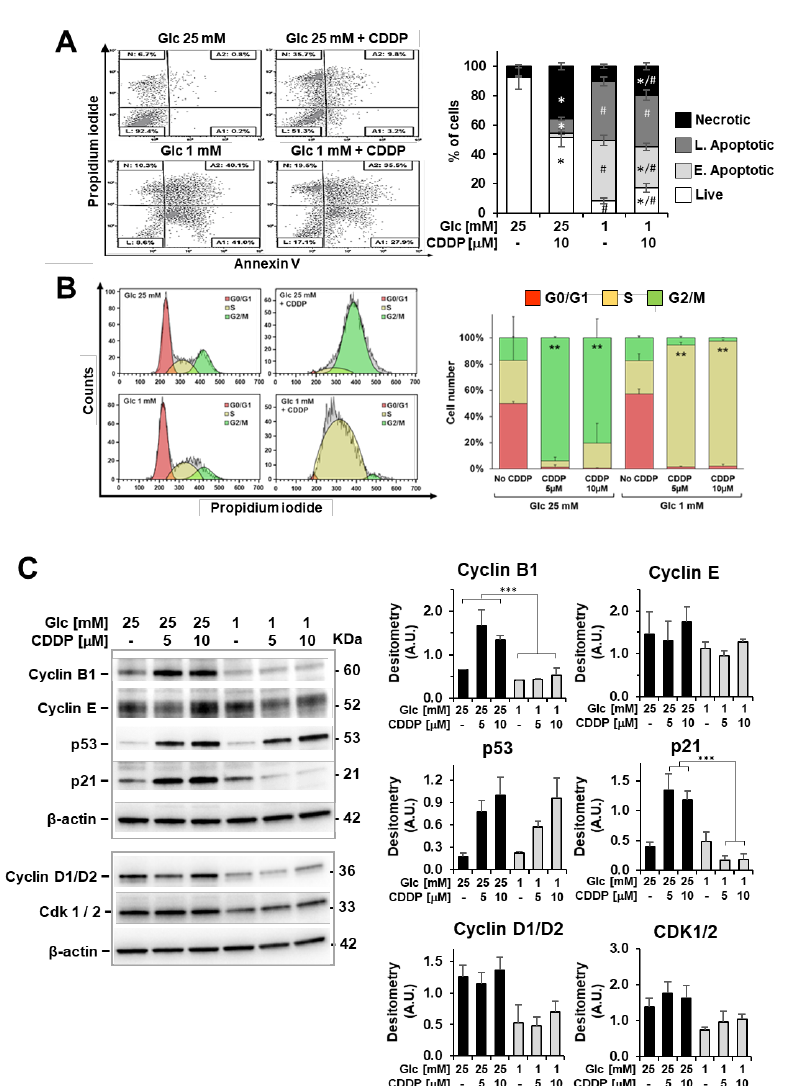
glucose pretreated 3AB-OS cells to CDDP. Left panel, representative growth curves of 3AB-OS cells pretreated with low glucose for 2 days and then exposed to CDDP (5 and 10 µM) or vehicle in low glucose nutrient medium for 72 h. Right panel, bar histogram: NCI values of low glucose-pretreated 3AB-OS cells relative to control (Glc 1 mM) after 72 h treatment. All data are presented as mean ± SD of three independent experiments. * p < 0.05; ** p < 0.01. Statistical significances are referred to the controls.